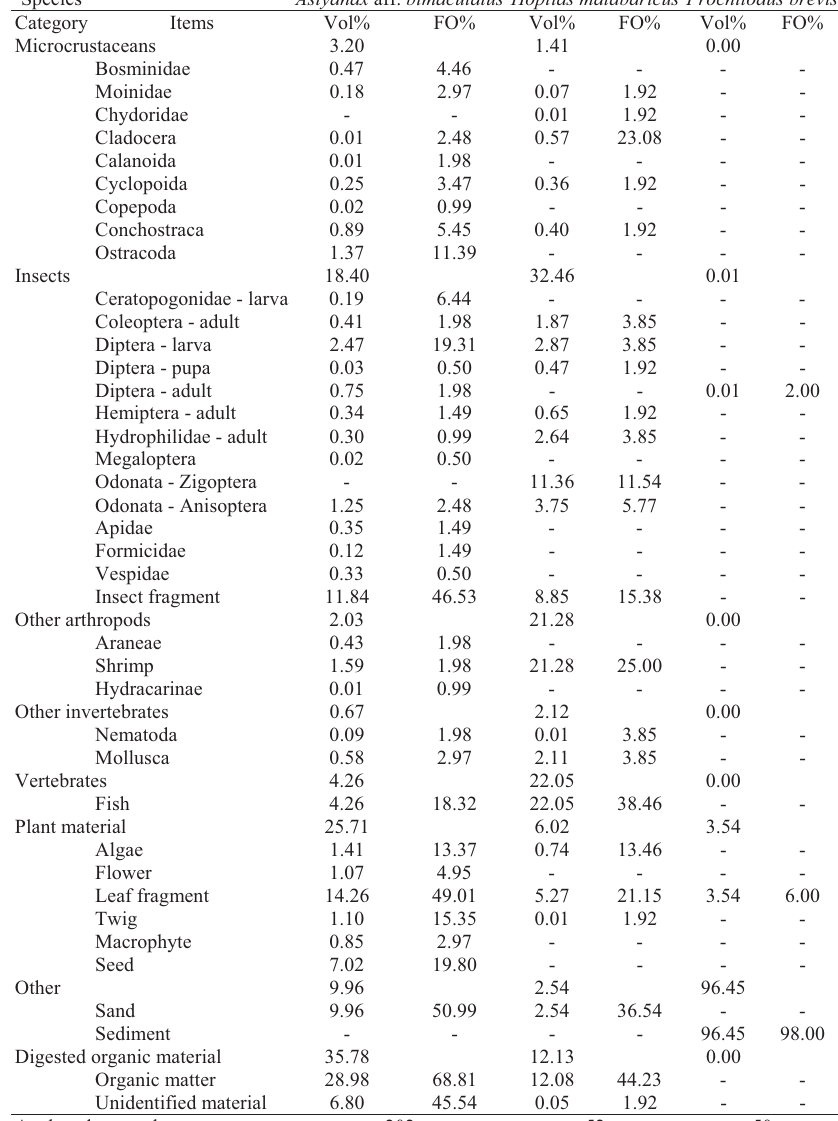
Table 2. Percentage of volume (Vol%) and frequency of occurrence (FO%) of macroscopic food items found in the diet of Astyanax aff. bimaculatus , Hoplias malabaricus and Prochilodus brevis , in aquatic habitats of the Brazilian semi-arid region. Contribution by percent volume of major categories is also